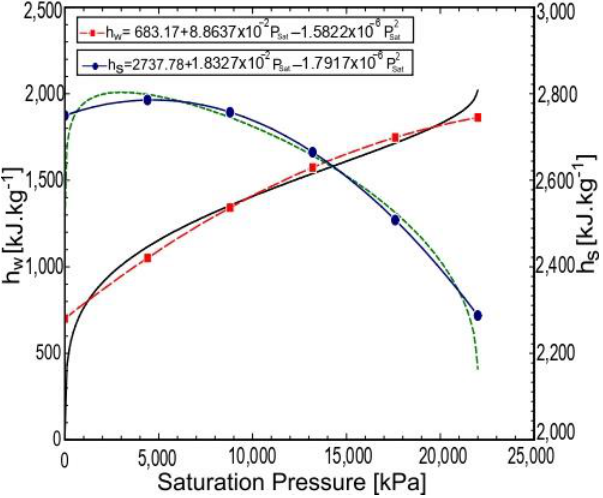
Figure 7. Graph used to determine the polynomials of enthalpy of water and enthalpy of steam, as a function of saturation pressure through linear regression (curve fitting) in the EES ® software.